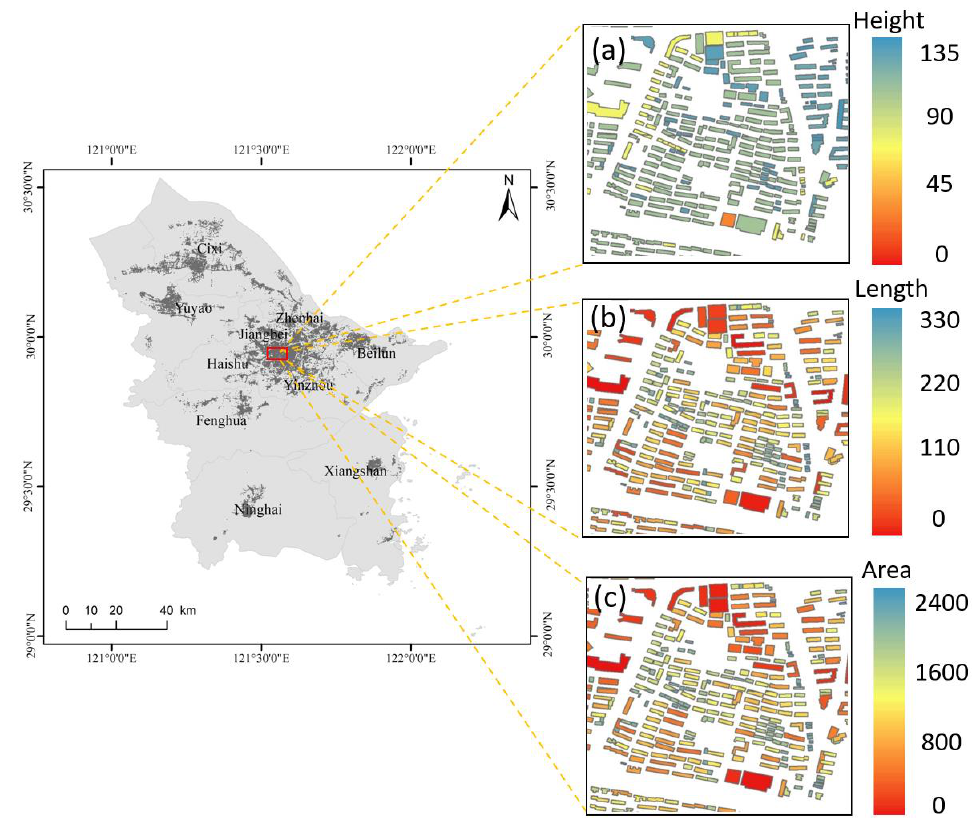
Figure 3. Building footprint of the study area. ( a ) building height distribution. ( b ) building length distribution. ( c ) building area distribution.